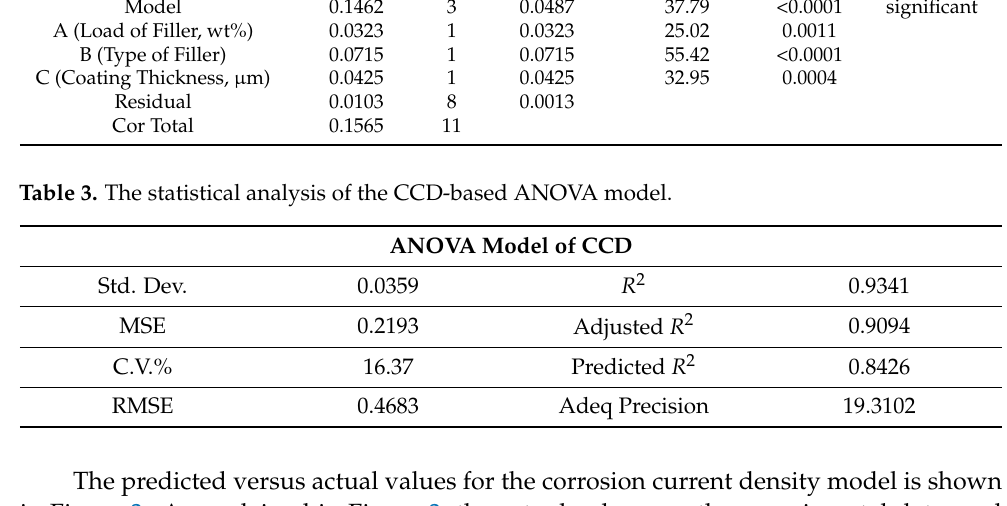
Table 2. ANOVA-based model of corrosion current density.